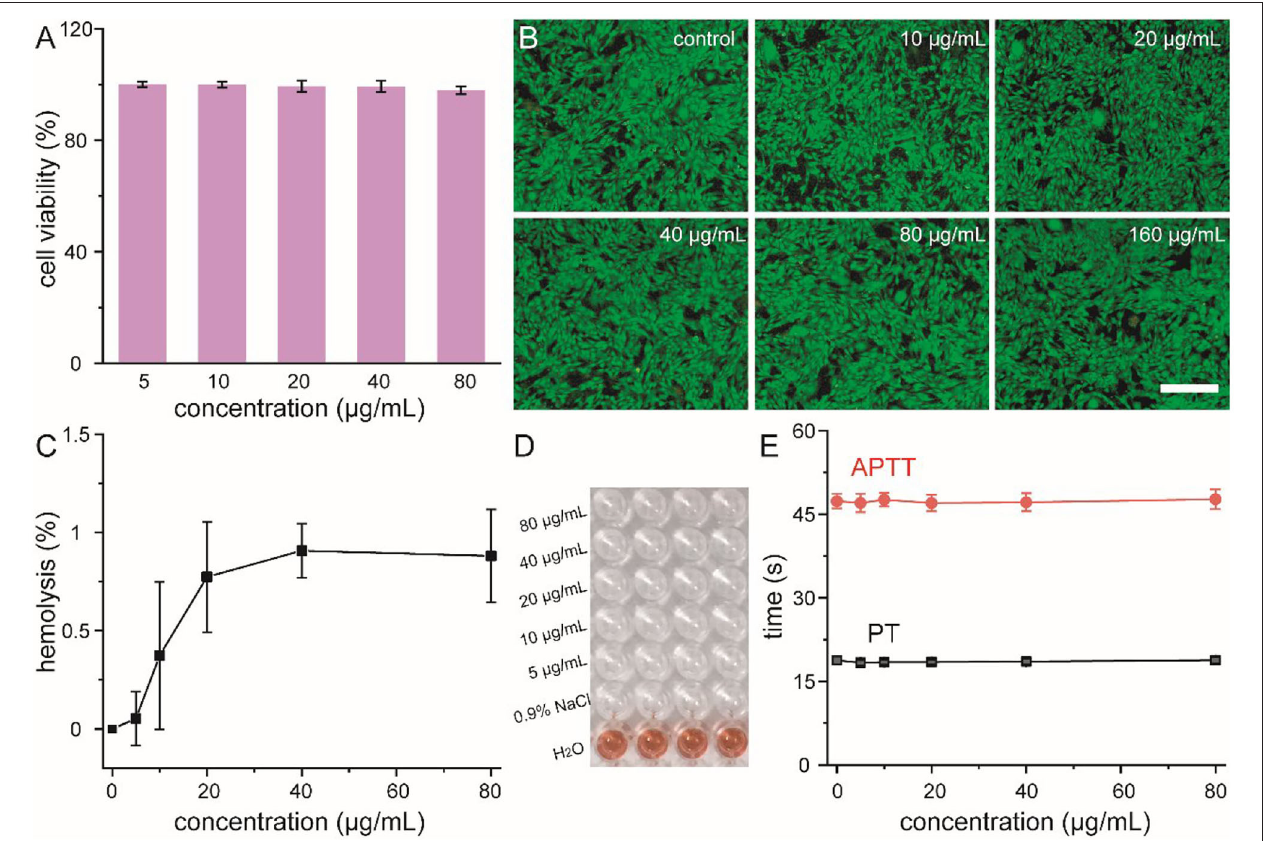
FIGURE 3 | Cell viability (A) and live-dead staining (B) of HUVEC cells treated with nanoflowers with different concentrations. Scale bar was equal to 100 µ m. Hemolysis percentages (C) of nanoflowers and relative photographic image (D) . Nanoflower-induced blood coagulation analysis (E)